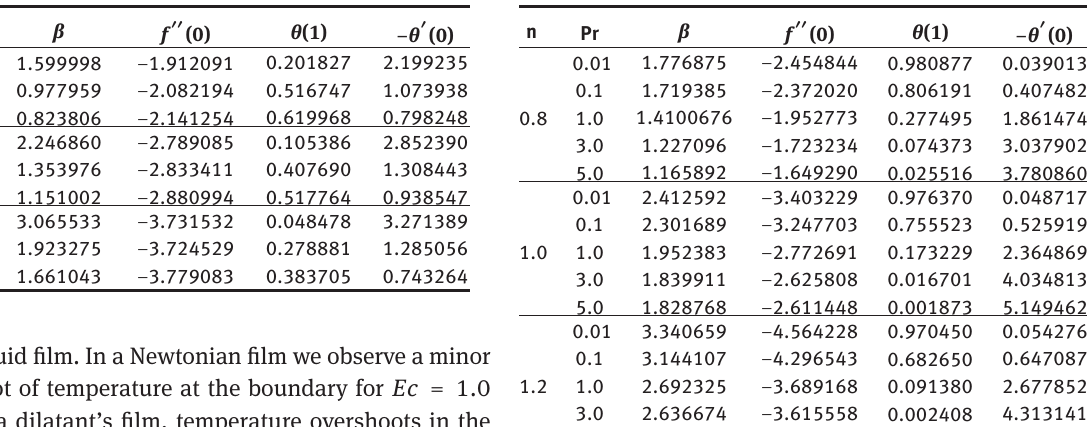
Table 5: Values for β , f (cid:2)(cid:2) (0) , θ (1) and − θ